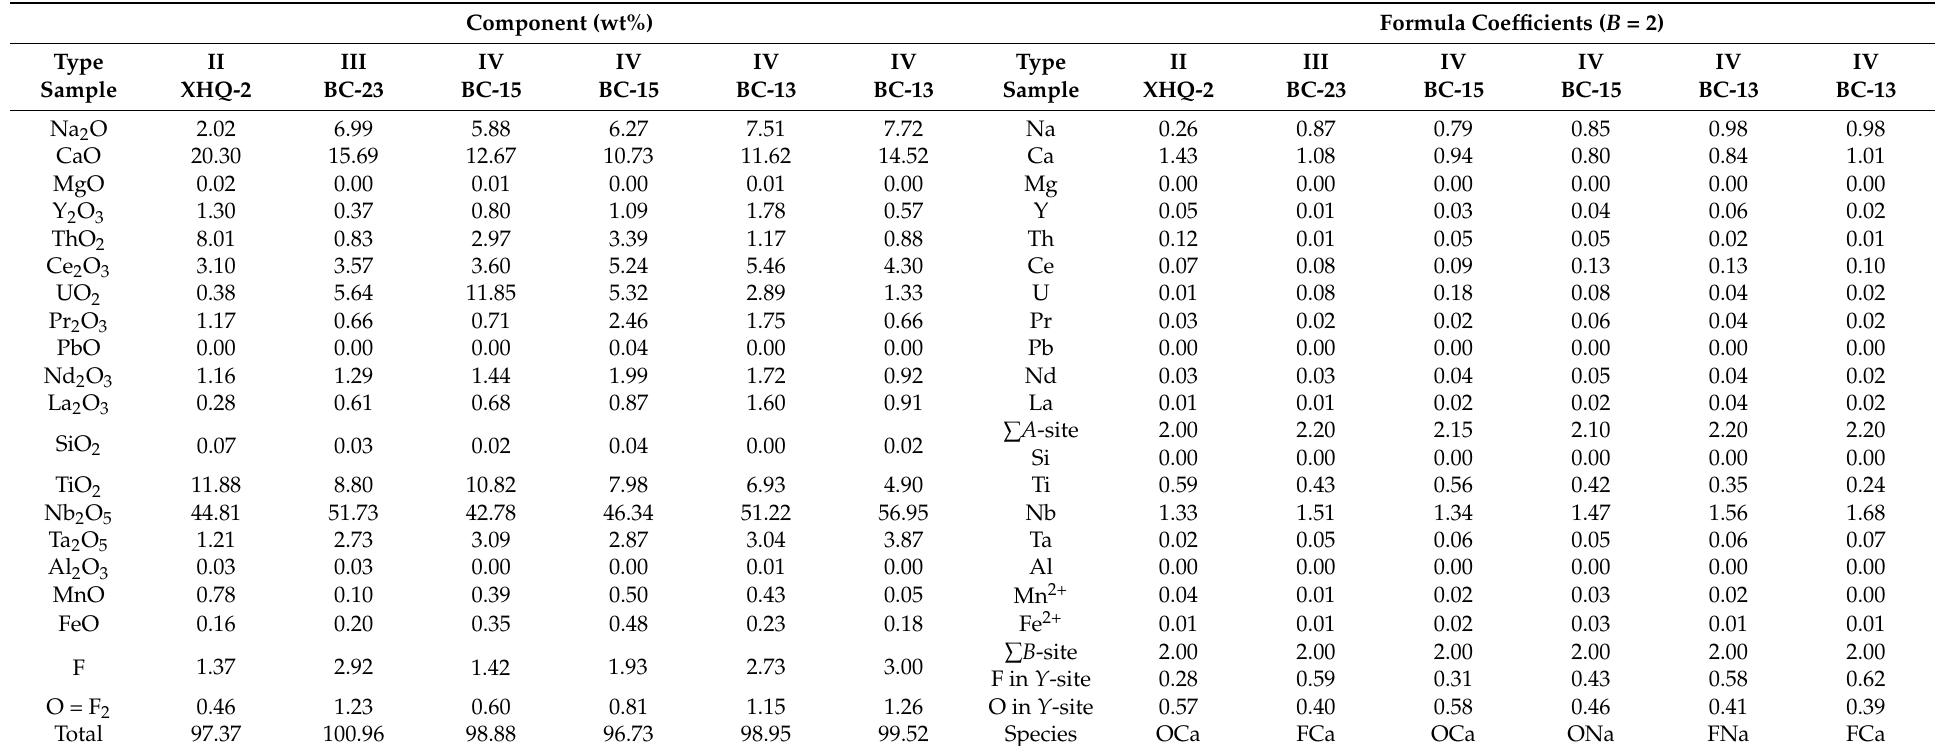
Table 2. Representative electron microprobe data for the pyrochlore group minerals from the syenitic dikes in the Huili